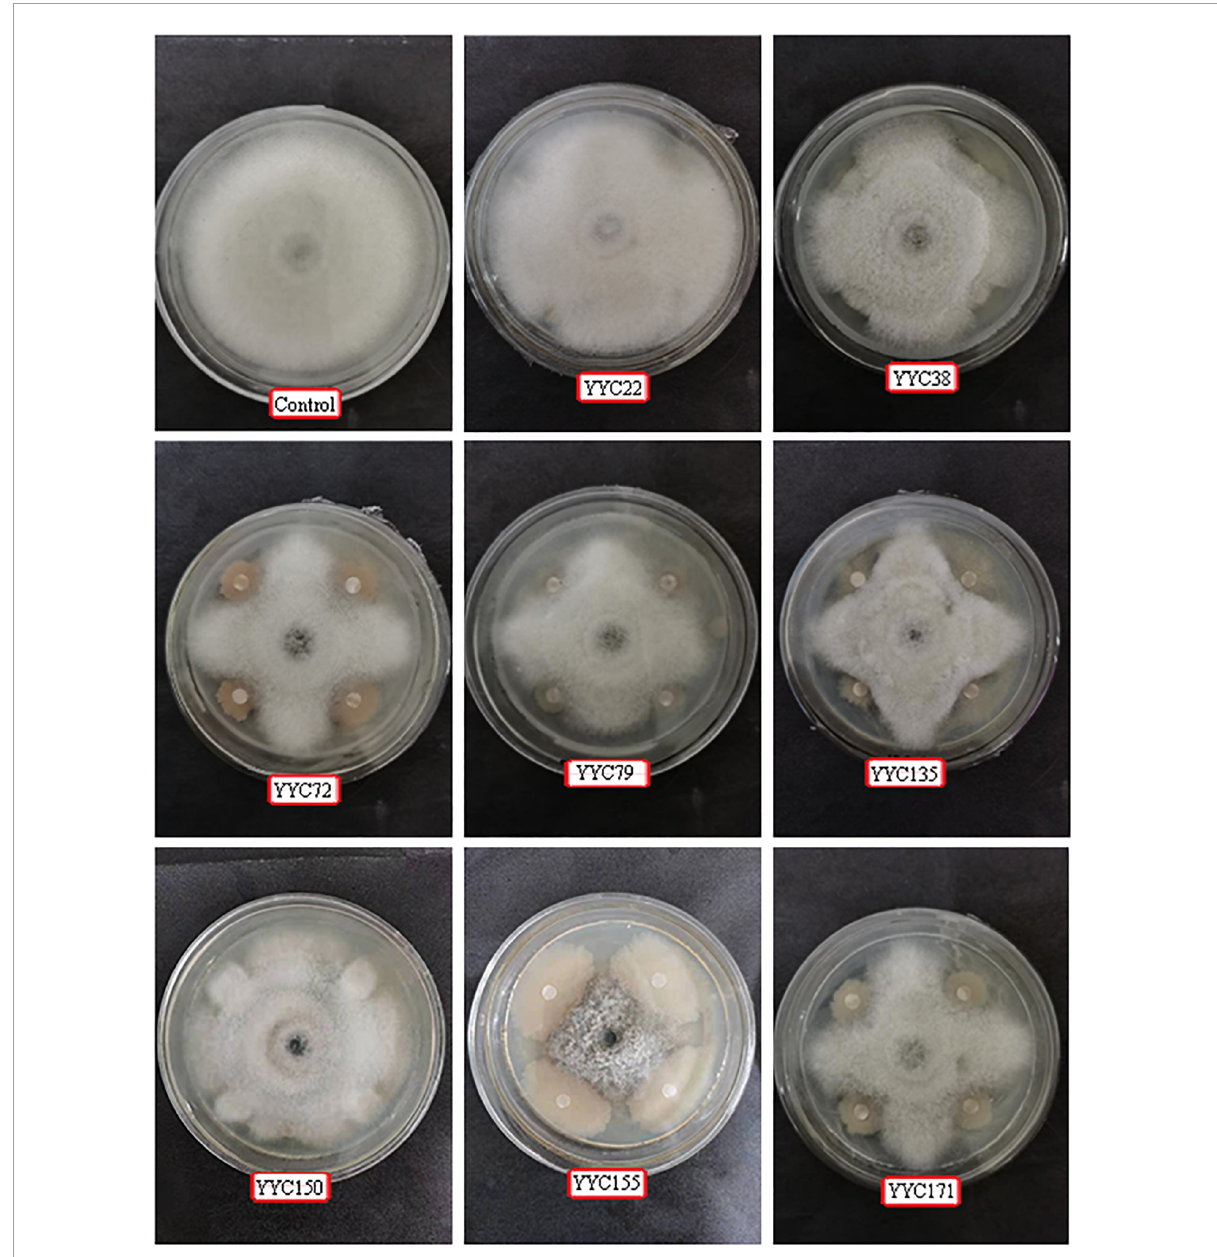
FIGURE1 Representative photos illustrating the antagonistic activity of eight bacterial strains isolated from root nodules of C. pallida against C. fructicola in vitro. Three independent replicates were used for different